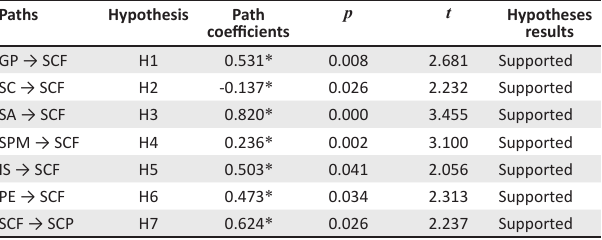
TABLE 5: Structural equation modelling hypotheses testing results.